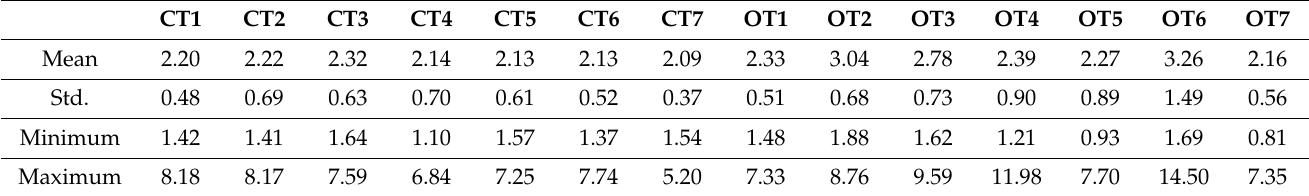
Table 11. Ambient air temperature differences of the unmitigated versus the mitigated scenarios for all